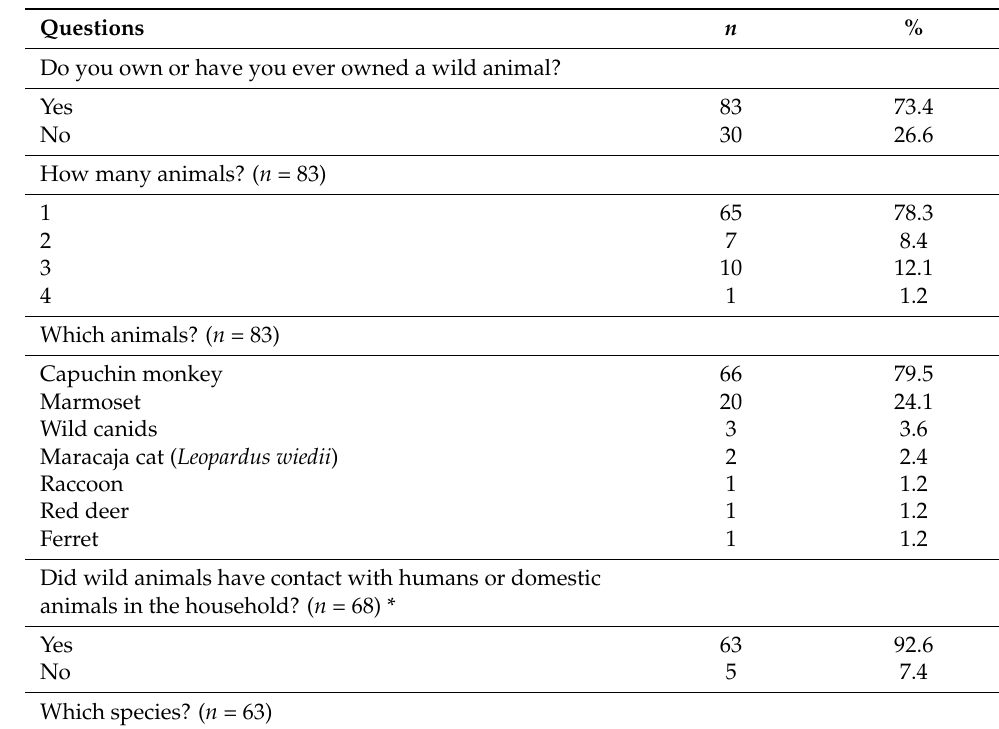
Figure 7. Examples of aggressions by wild animals to humans: (a) bite by a capuchin monkey at the leg of a person; (b) marmoset aggression on the index finger of a person. Table 6. Wild animals kept as companion animals, aggression and the type of contact between humans and animals on the respondents’ properties, Ceará, Brazil, 2019 ( n = 113).